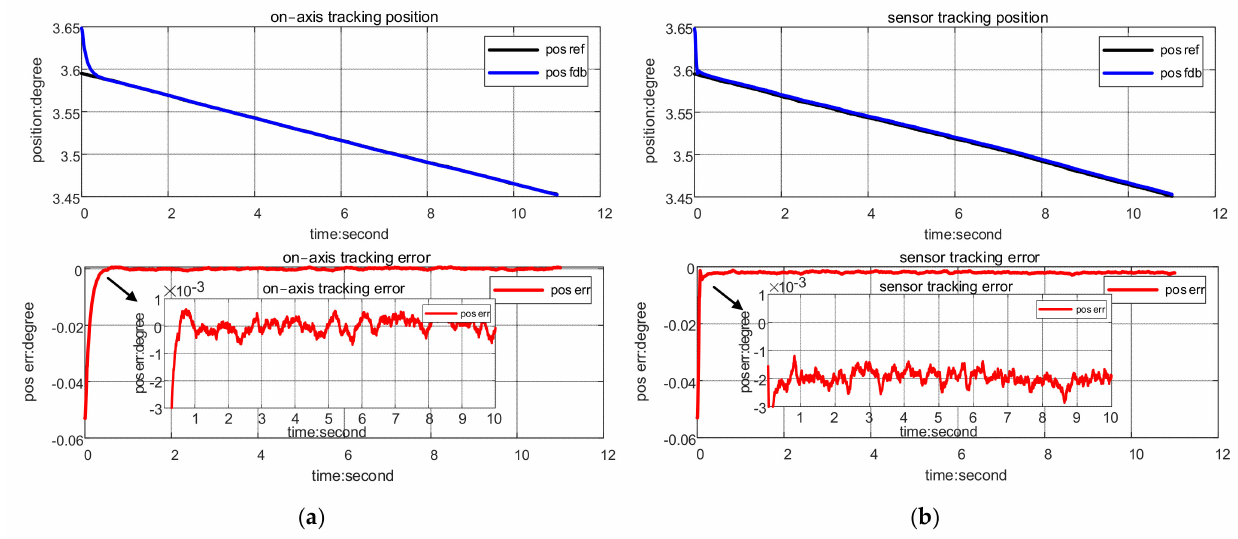
Figure 8. ( a ) tracking position curve of on-axis tracking control; ( b ) tracking position curve of closed-loop